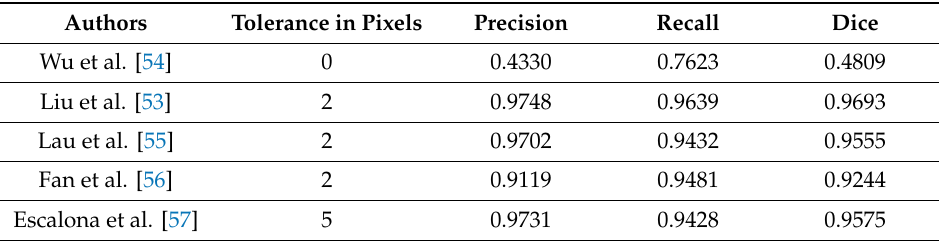
Table 1. Best results on CrackForest dataset.